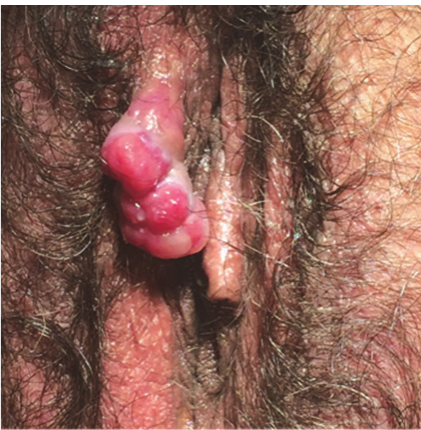
Figure 1: Image of the vulvar lobular capillary hemangioma.